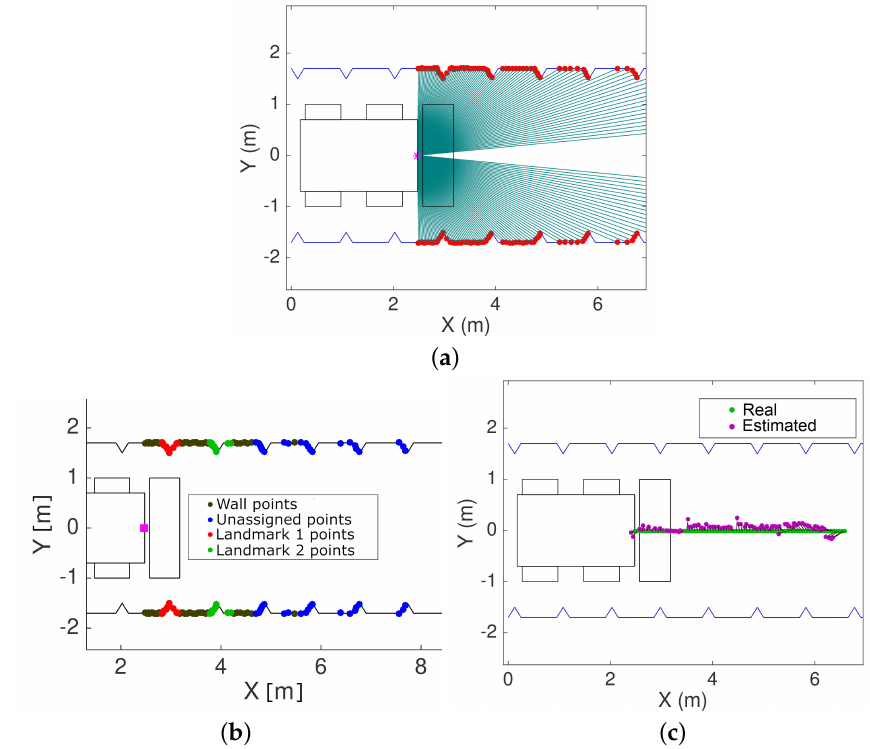
Figure 3. Top view of an ideal tunnel with triangular landmarks showing the matching of noisy lidar measurements to the map ( a ), the classification of landmark and wall points ( b ), and the estimated position using the proposed methodology ( c